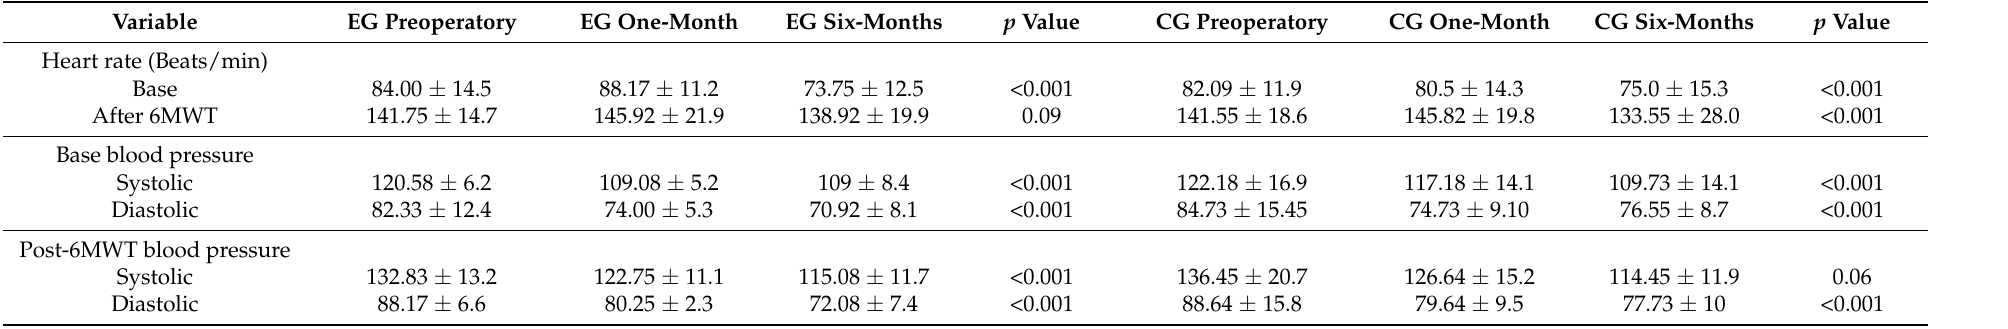
Table 4. 6MWT cardiovascular parameter